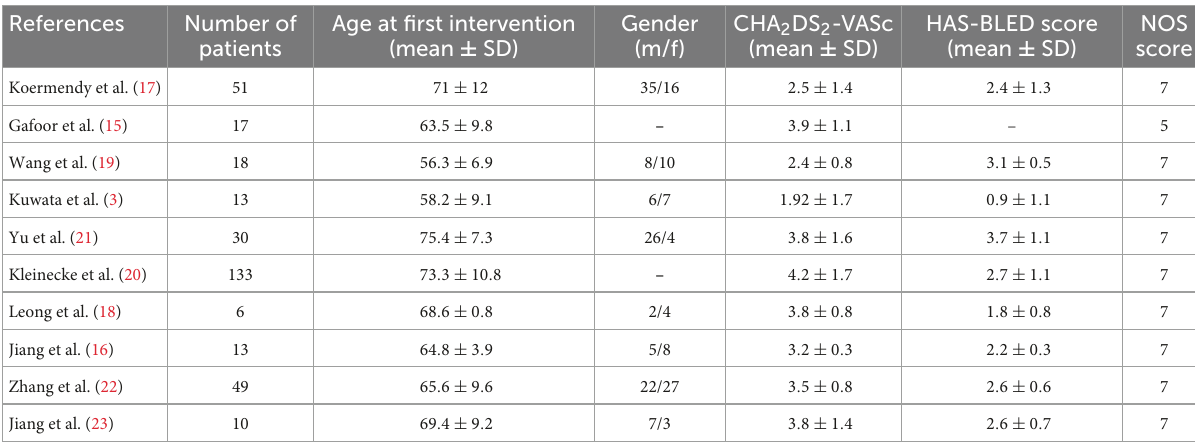
TABLE 1 Clinical